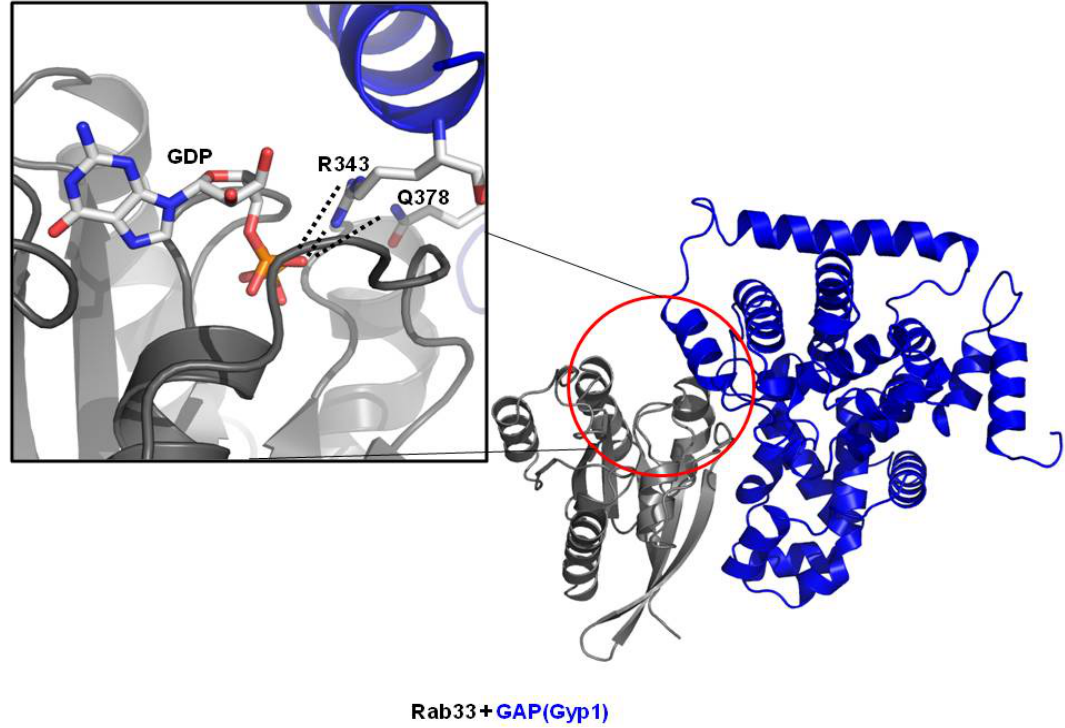
Figure 2. Crystal structure of Rab33/Gyp1 complex (PDB ID: 2G77)—The representative Rab/GAP complex structure. Close-up view shows the involvement of arginine finger and glutamine finger in the interaction with GDP. R343 is arginine finger and Q378 is additional glutamine finger. Salt bridges are shown by dotted